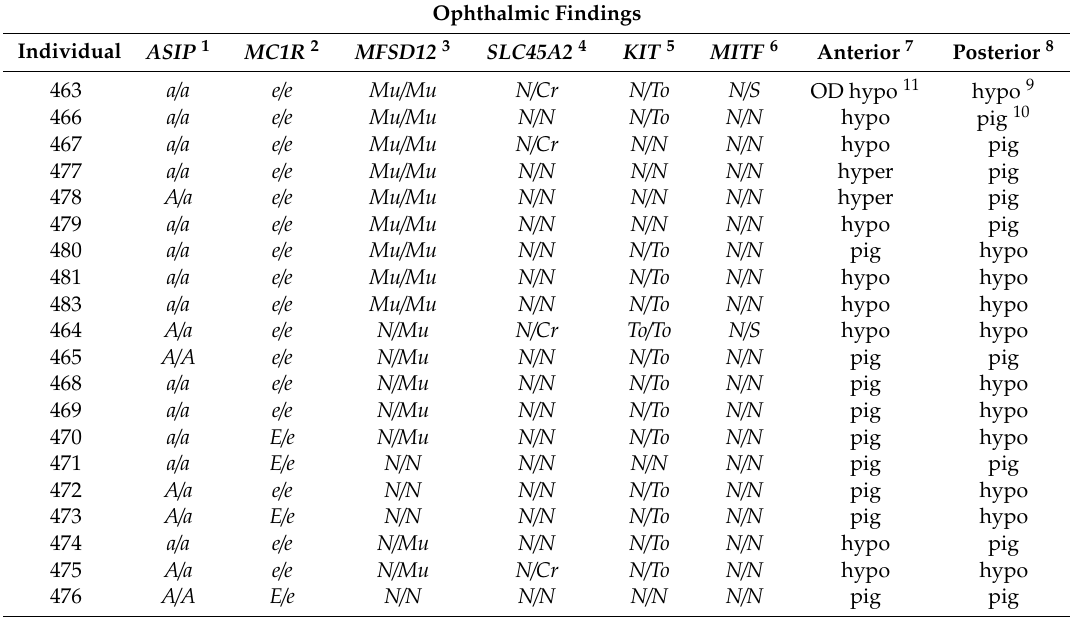
Table 6. Ophthalmic Findings in Mushroom Ponies. A complete ocular exam was performed on twenty Shetland Ponies Genotypes for coat color with variation in the sample set are also